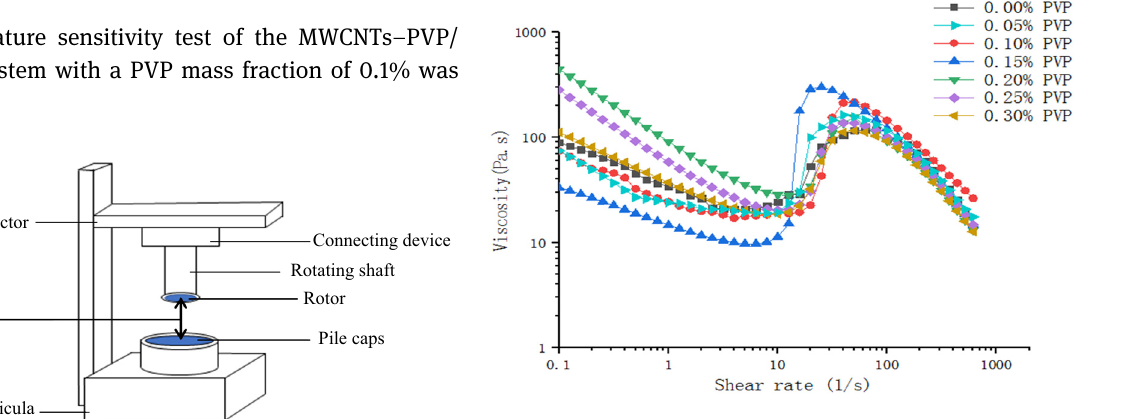
Figure 2: The steady - state rheological properties of the MWCNTs – PVP/SiO 2 – STF system with di ff erent mass fraction